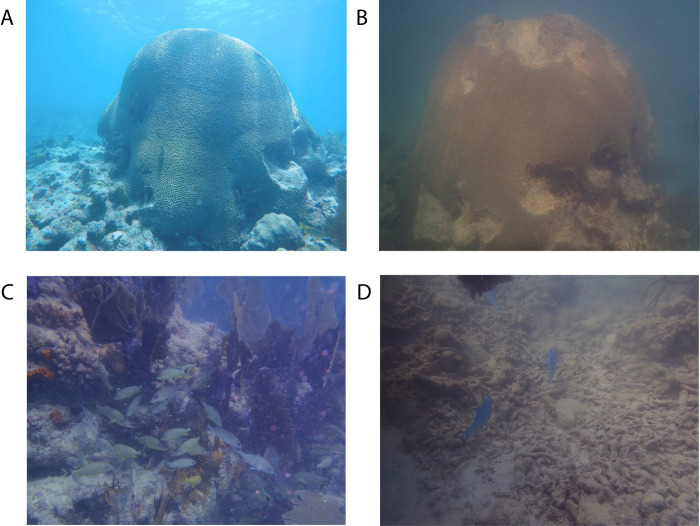
Before-after impacts of hurricane Irma on coral reefs in the Florida Keys, with before images taken in August 2017 and after images taken in December 2017.(A) Brain coral at Eastern Sambo study site taken in August 2017 and (B) its structural damage after Irma in December 2017. (C) Divers observed fish aggregations near and underneath collapsed reef ledges at Looe Key reef (~26 km northeast of Eastern Sambo study site), and the (D) same site with high amounts of reef rubble after Irma. Photo credit K. Simmons.